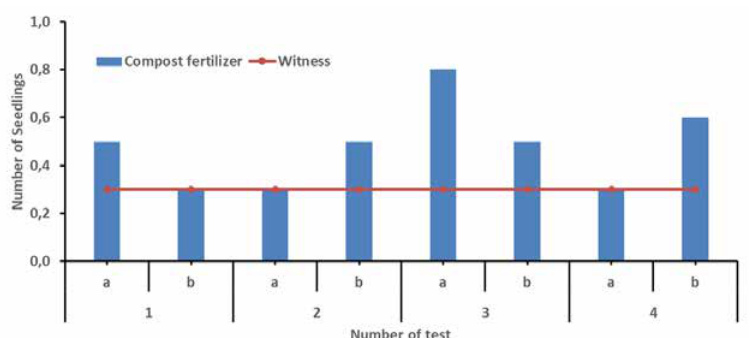
Fig. 4: Averages of the number of ears harvested by plants in each treatment, a = dose of 100 g, b = dose of 200 g